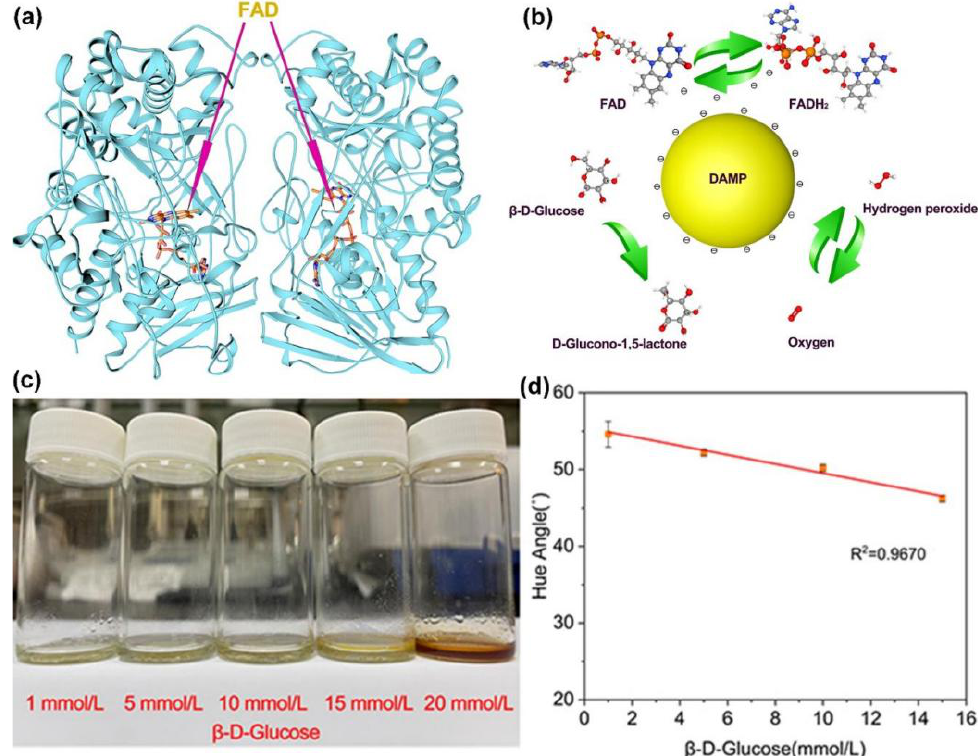
Figure 9. ( a ) Ribbon structure diagram of GOx homodimer; ( b ) diagram of the catalytic mecha- nism of DAMP; ( c ) the colorimetric sensing photo of glucose; ( d ) the linear fit for color phase an- gles in the range of 1–15 mmol/L (n = 5).